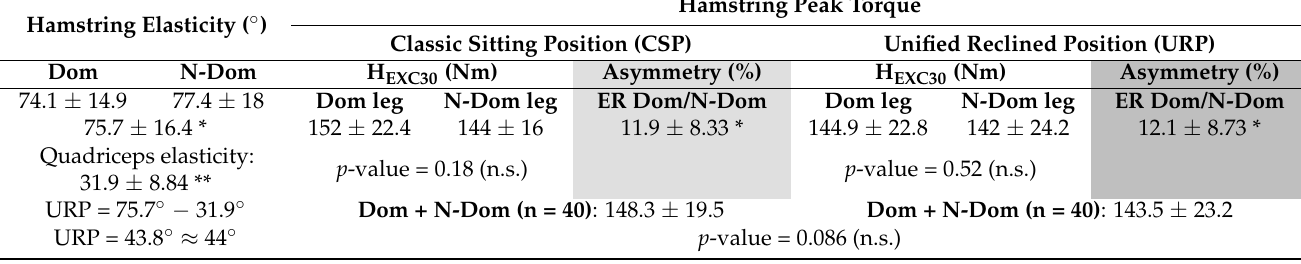
Table 1. Condition of the hamstring and quadriceps musculature: elasticity and eccentric PT in a 30 ◦ /s knee extension (H EXC30 ). The data for each group (n = 20) are reported as mean and standard deviation (mean ±